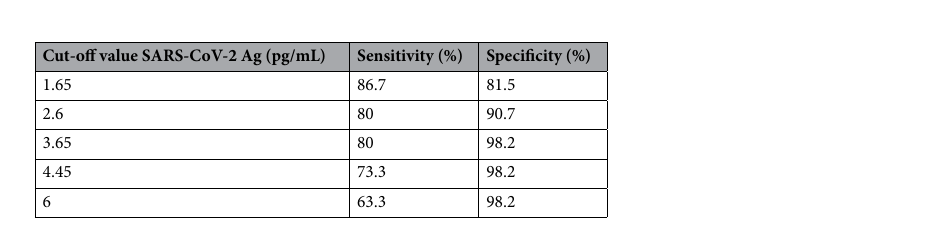
Table 4. Sensitivity and specificity according to various cut-off values. SARS-CoV-2 severe acute respiratory syndrome coronavirus 2.